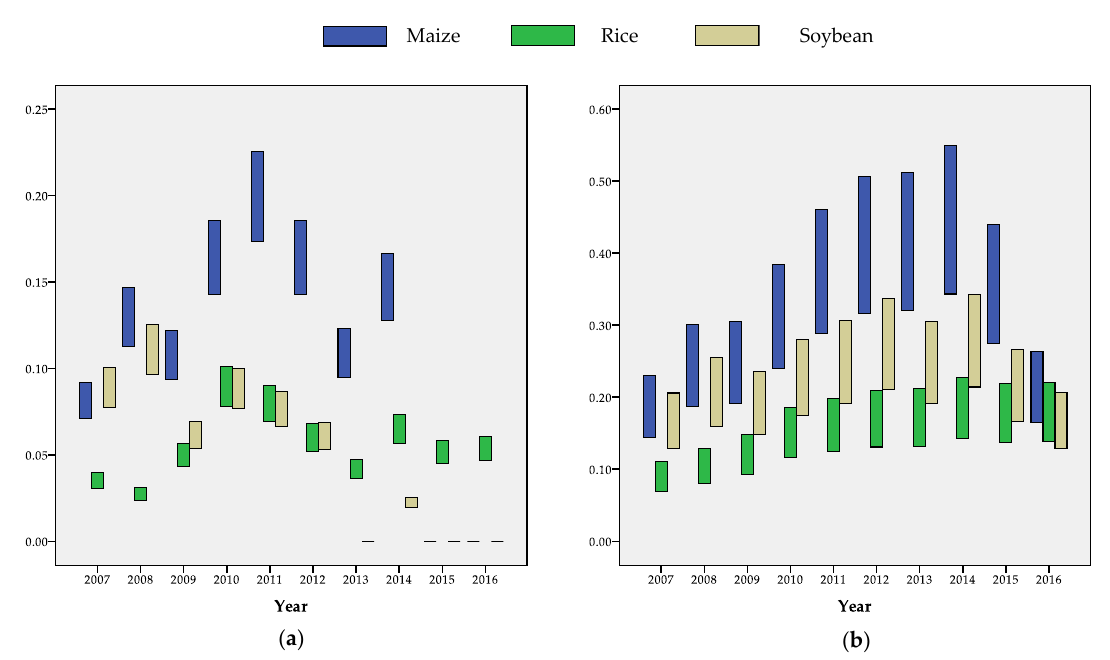
Figure 3. Ranges of affordable water prices for the three main crops between 2007 and 2016: ( a ) 10–13% of net income per hm 2 , and ( b ) 5–8% of output per hm 2 .